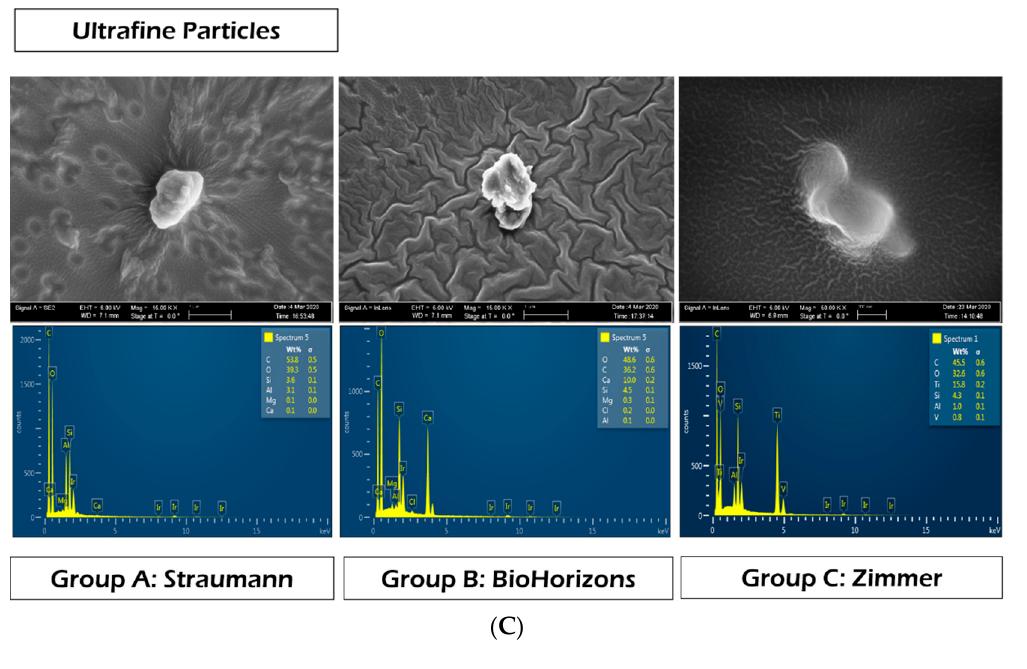
Figure 6. SEM-EDS analysis for ( A ) coarse particles; ( B ) fine particles; ( C ) ultrafine particles. The compressive properties of the tested implants are shown in Table 3. From the results it can be seen that the Ti15Zr alloy had the highest hardness values and the Ti6Al4V alloy used in Zimmer dental implants had the highest mechanical strength values. The BioHorizons dental implants, which have the same alloy as Zimmer, had significantly lower values than the Straumann and Zimmer implants due to the laser treatment to which the dental implants are subjected. Table 3. Compressive properties of the debris studied. The standard deviation is given in brackets.